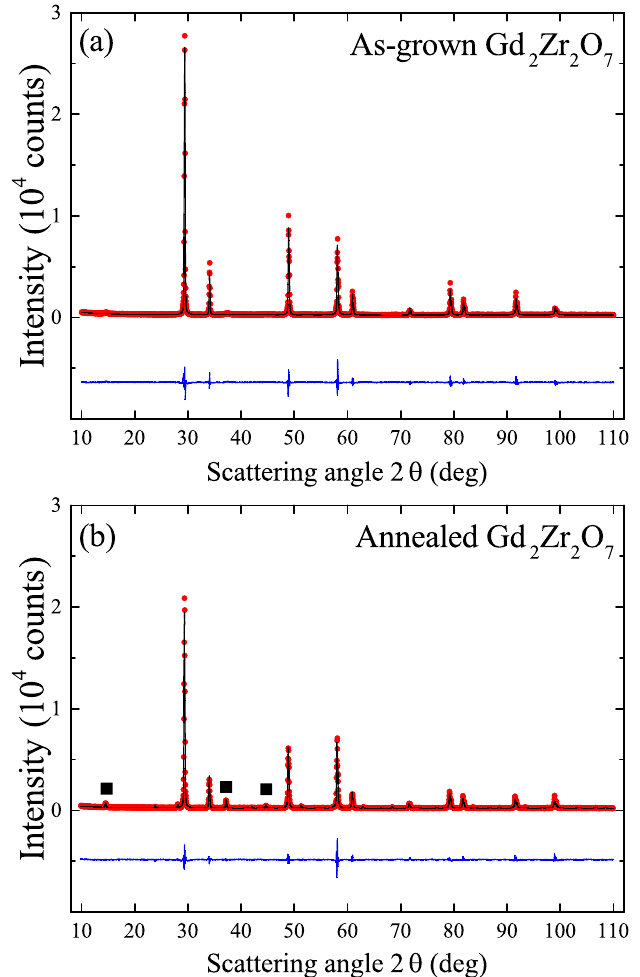
Figure 14. ( a ) Room temperature powder X-ray diffraction pattern collected on an as-grown ground boule of Gd 2 Zr 2 O 7 prepared in air using a growth rate of 15 mm/h from starting material with the pyrochlore structure, GZO_1; ( b ) Powder X-ray diffraction profile of an annealed boule of Gd 2 Zr 2 O 7 (the annealing was carried out in air at 1400 ˝ C for several days). The experimental profile (red closed circles) and a full profile matching refinement (black solid line) to the defect-fluorite ( a ) and pyrochlore ( b ) structures are shown, with the difference given by the blue solid line. ” (cid:110) ” indicate the low angle superlattice reflections of the pyrochlore